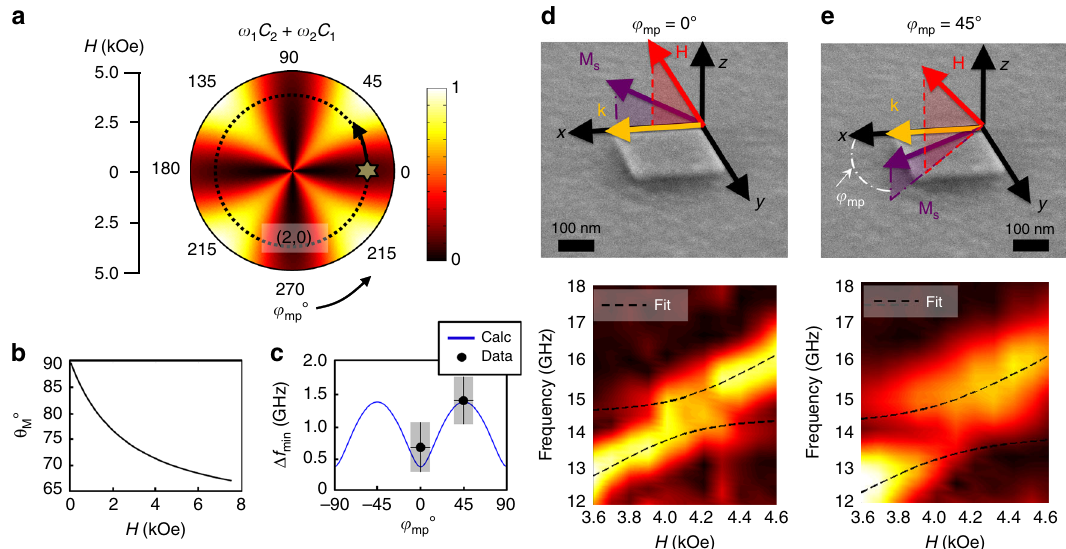
Fig. 3 Externally tuning the coupling of the (2,0) mode into the strong coupling regime. a Normalized H vs. φ mp plot of the weighted angular coupling term ( ω 1 C 2 + ω 1 C 1 ). b Due to the experimental geometry, only certain out of plane angles of the magnetization θ M were accessible for the range of applied fi elds employed in the experiment. c The calculated frequency splitting as a function of φ mp (dotted line in a ) as well as the minimum frequency splitting taken from the data. The y-error was calculated from the FFT resolution. For the x-error a resolution of ±10° was assumed for the in-plane positioning of the nanomagnet. d The experimental con fi guration and the measured spectra with fi ts to Eq. (3) when the magnetization is oriented along the edge of the square so that it is parallel with the (2,0) phononic mode and ( e ) after rotating the nanoelement so that φ mp = 45°. The spectrum shows an increase